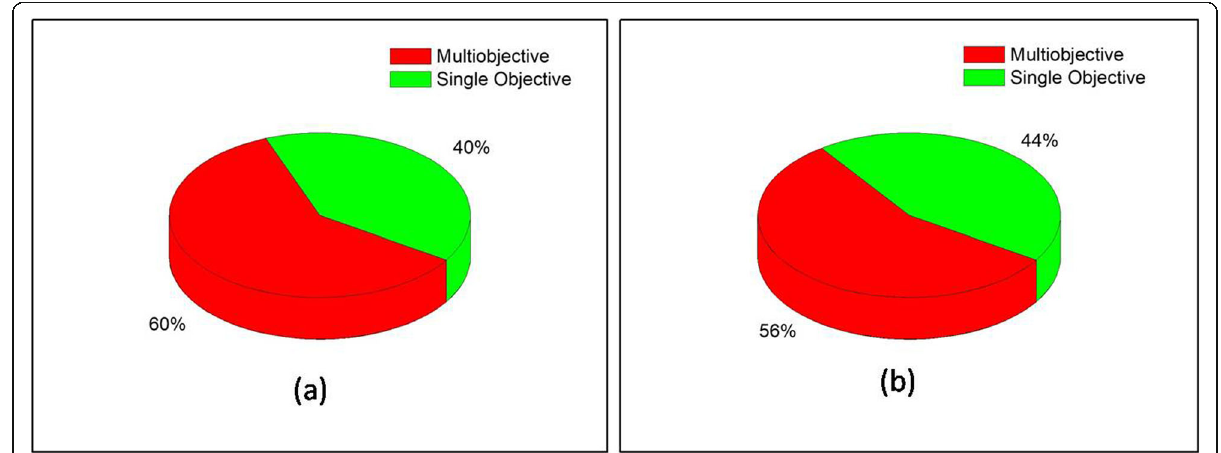
Fig. 10 Percentage of multi-objective and single objective algorithms in proactive and reactive